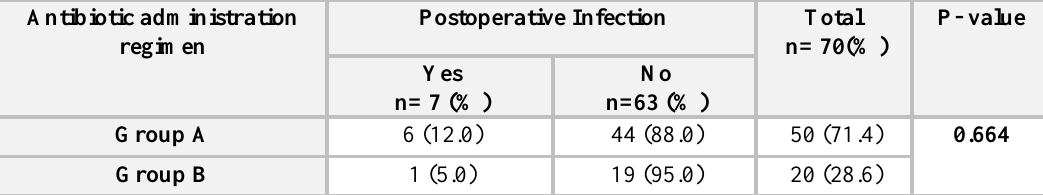
Table (6): Association between the incidence of post-operative infection in closed and open